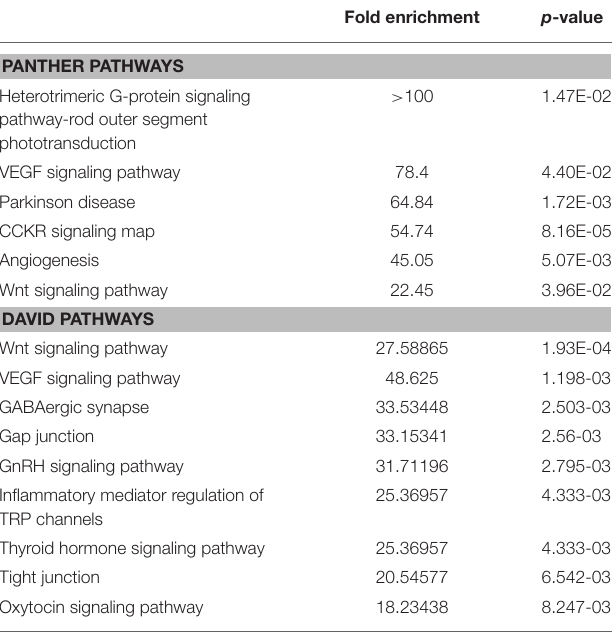
TABLE 8 | Enrichment analysis of the kinases substrate motifs that are more relevant in the PCA analysis of phospho-sites differently expressed in ns-Zr15 vs